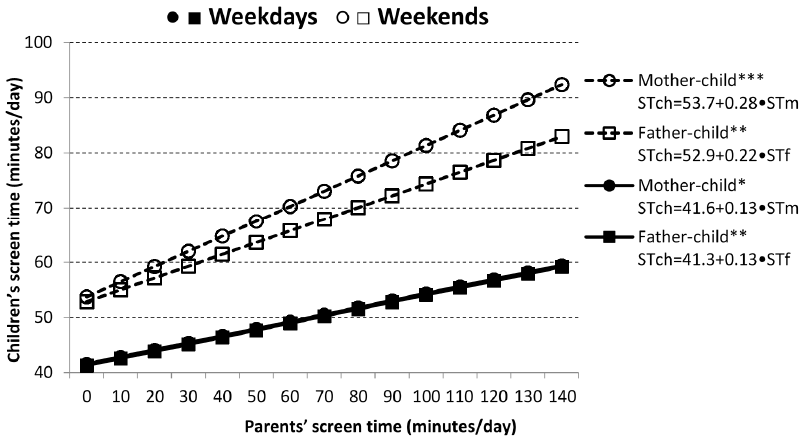
Figure 1. Relationship between parents’ and children’s daily step count (SC). SCch—step count of